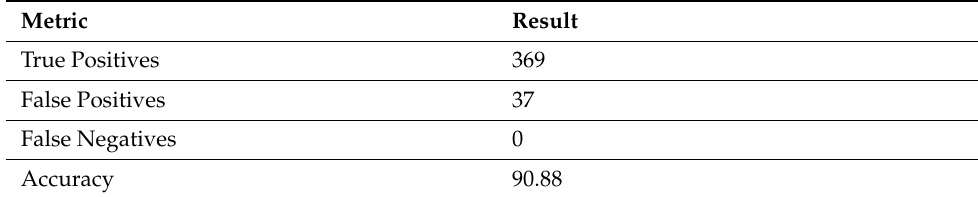
Figure 7. Results using GIS software, and three zoomed areas ( A – C ), in which the different colored objects represent different instances from wind plants. Table 6. Per-object metrics considering the true positives, false positives, false negatives, and overall